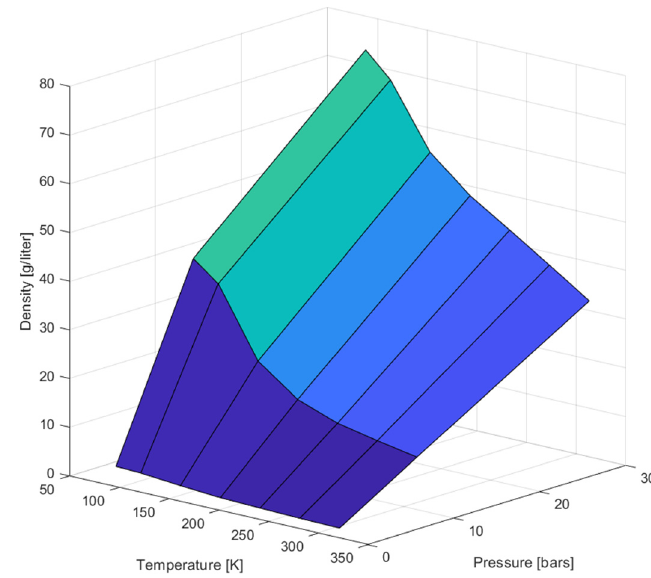
Figure 12. Nitrogen density as a function of pressure and temperature.